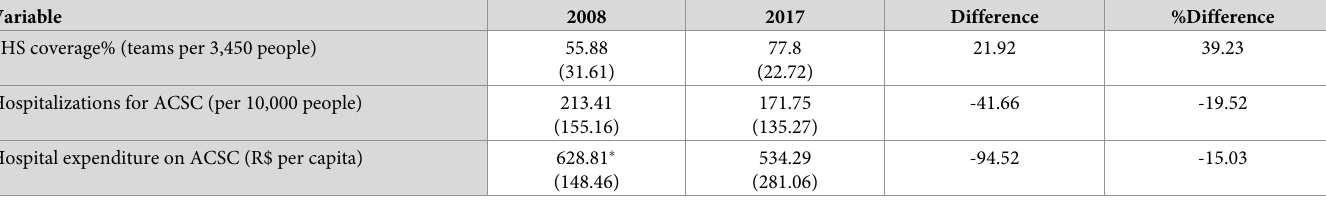
Table 2. Descriptive statistics of the study